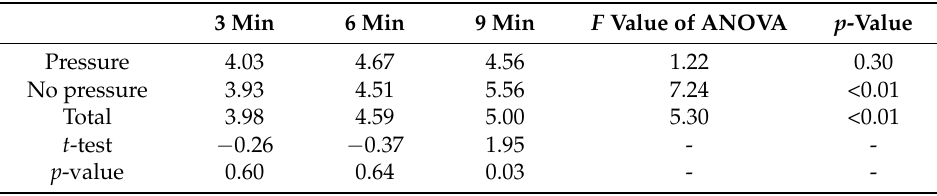
Table 2. Service time